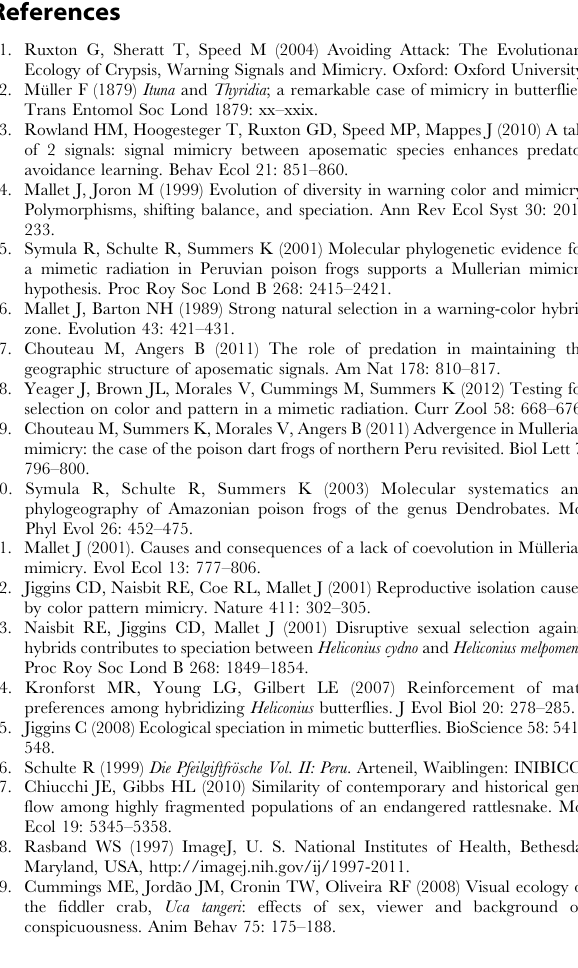
Table S7 Raw counts for relative abundance analysis. Numbers refer to the number of individuals found for that species in that site. A zero is given for cases where that species is assumed to occur at that site but was never found. Blank fields indicate the species is likely absent from that site. The superscript ‘‘m’’ indicates the putative model species at a given site. For the two transition zone populations, no model species is specified because the R. imitator phenotypes do not necessarily correspond to any model